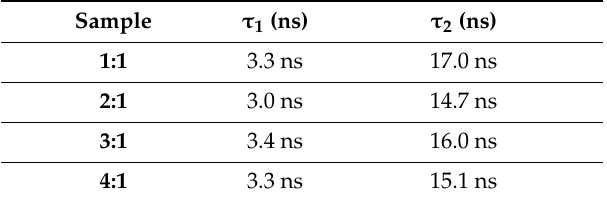
Figure 8. TCSPC measurements of 521 nm fluorescence excited at 360 nm for different molar ratios of precursors. The amplitude of the decay signal has been normalized to compare the behavior of the different samples. Table 2. TCSPC fit